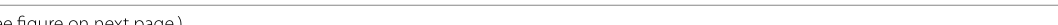
figure on next Fig. 2 A Regional belemnite species richness rarefied to 20 specimens where possible. Boxes refer to the relative availability of localities with a suitable sample size; B belemnite raw species richness (updated curve) compared to the corresponding estimators Chao 2 (light grey line) and ICE (grey dotted line); confidence intervals for raw richness are derived from the unconditional variance computed for sample ‐ based rarefaction; for the Chao 2 estimator, only the lower bound of the 95% confidence interval is shown for clarity; C Belemnite species richness rarefied or extrapolated to 16 localities and associated 95% confidence intervals; data are plotted at the mid ‐ points of the time scale of Gradstein et al. (2012). The lower part of the figure shows the chronostratigraphic framework used here (Ja, Jamesoni; Ib, Ibex; Da, Davoei; Ma, Margaritatus; Sp, Spinatum; Te, Tenuicostatum; Se, Serpentinum; Bi, Bifrons; Va, Variabilis; Th, Thouarsense; Di, Dispansum; Ps, Pseudoradiosa; Aa, Aalensis). Red arrows and dotted vertical red lines indicate the two pulses of the second ‐ order Toarcian